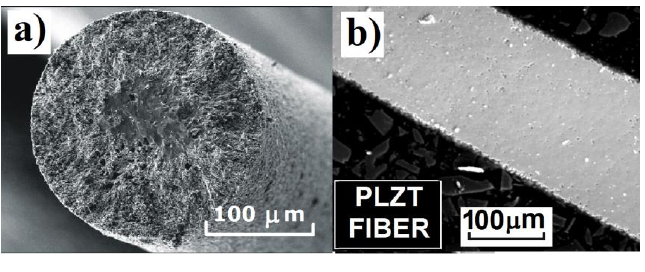
Figure 2. SEM images of the fracture surface of PLZT fiber ( a ) and polished cross section of the investigated fiber ( b ).